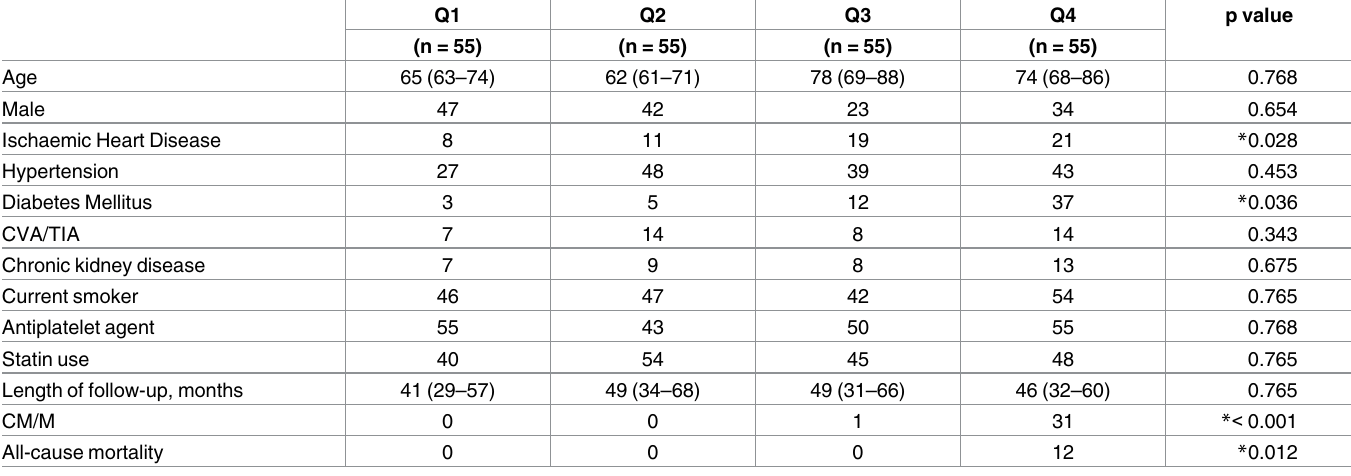
Table 4. Baseline characteristic and clinical outcomes by Bollinger score quartiles.